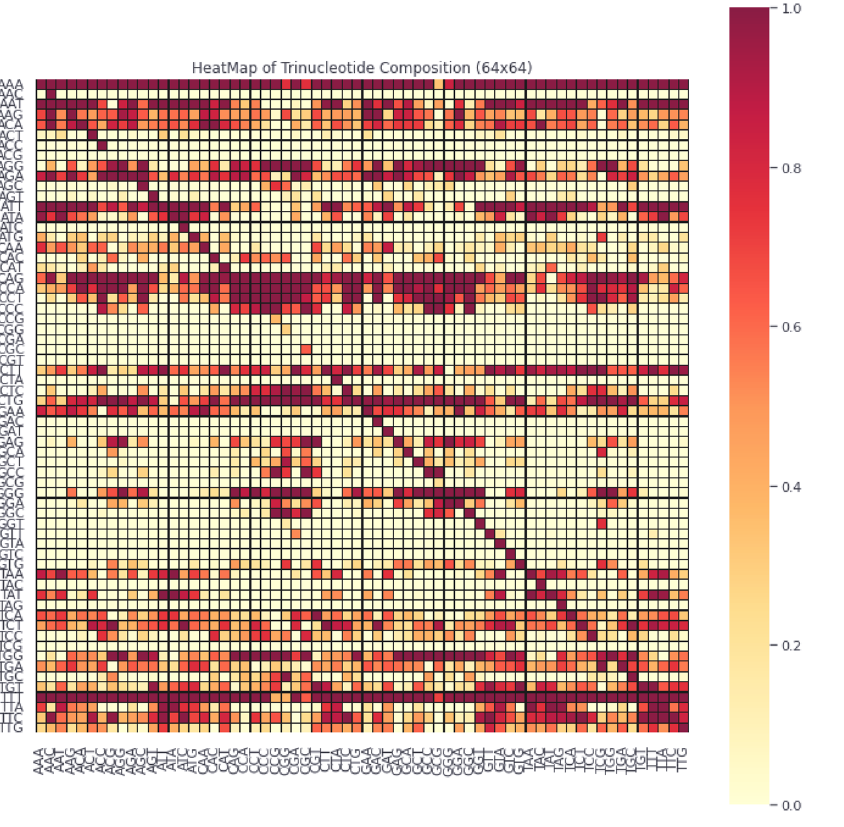
Figure 3. The heatmap of trinucleotide composition based